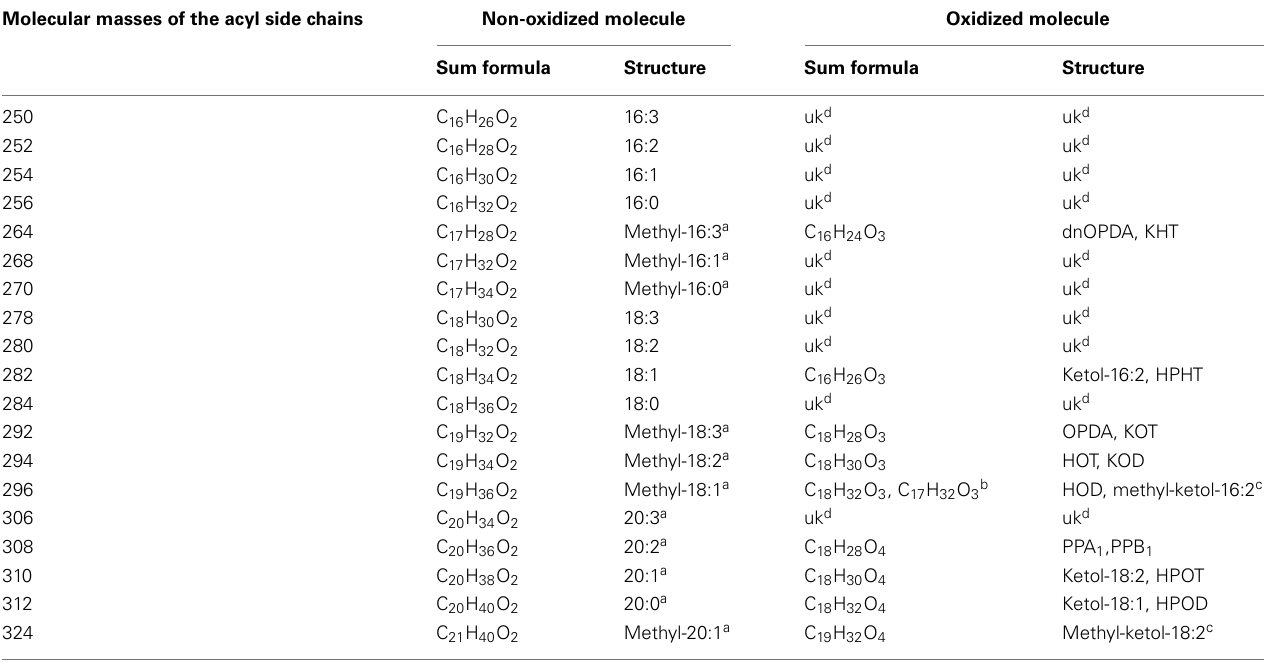
Table 5 | Molecular masses of the detected acyl side chains and the appropriate sum formulas and structures of the respective non-oxidized or oxidized molecular versions.